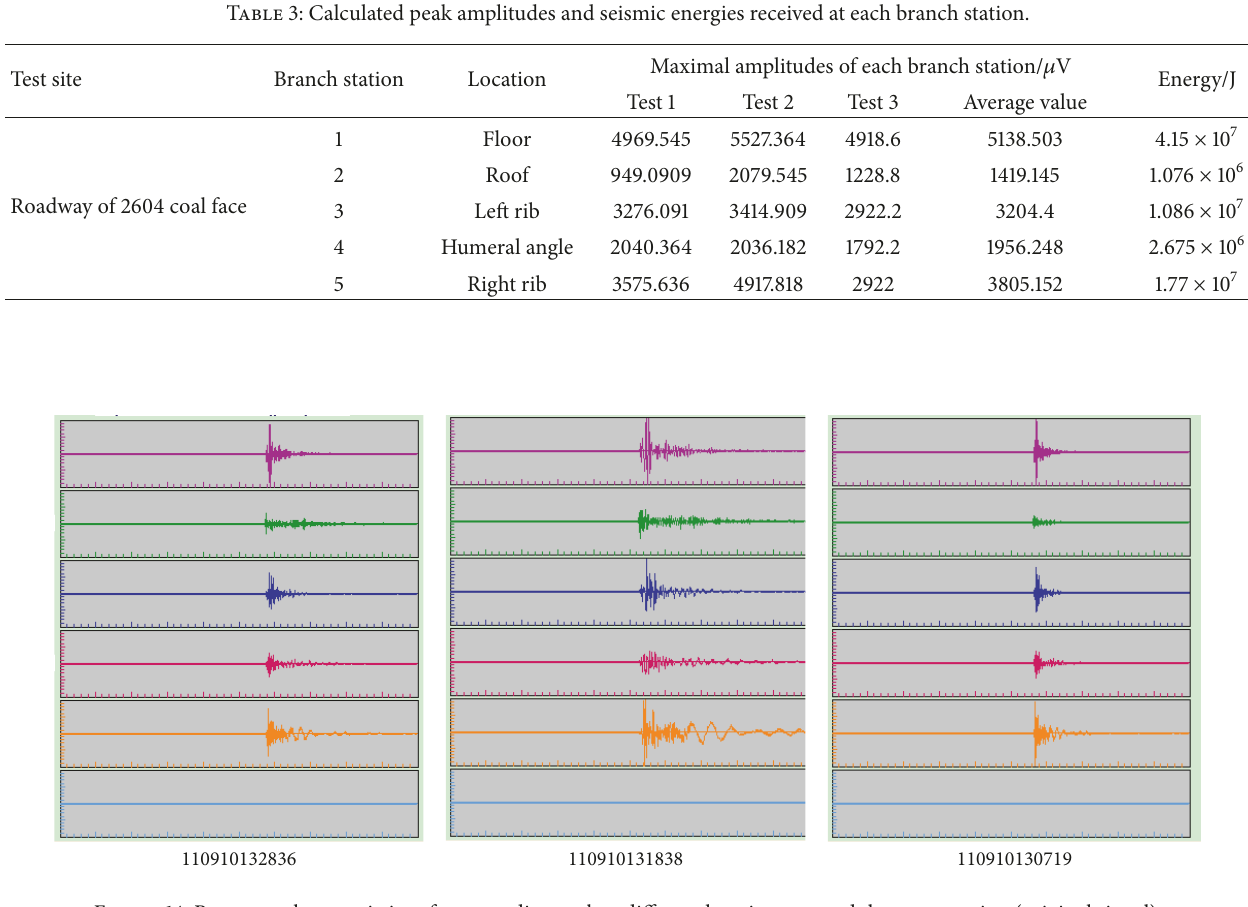
Figure 14: Response characteristics of surrounding rock at different locations around the same section (original